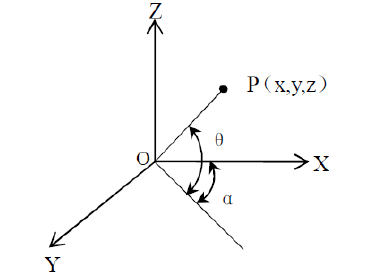
Figure 2 Three-dimension coordinate system